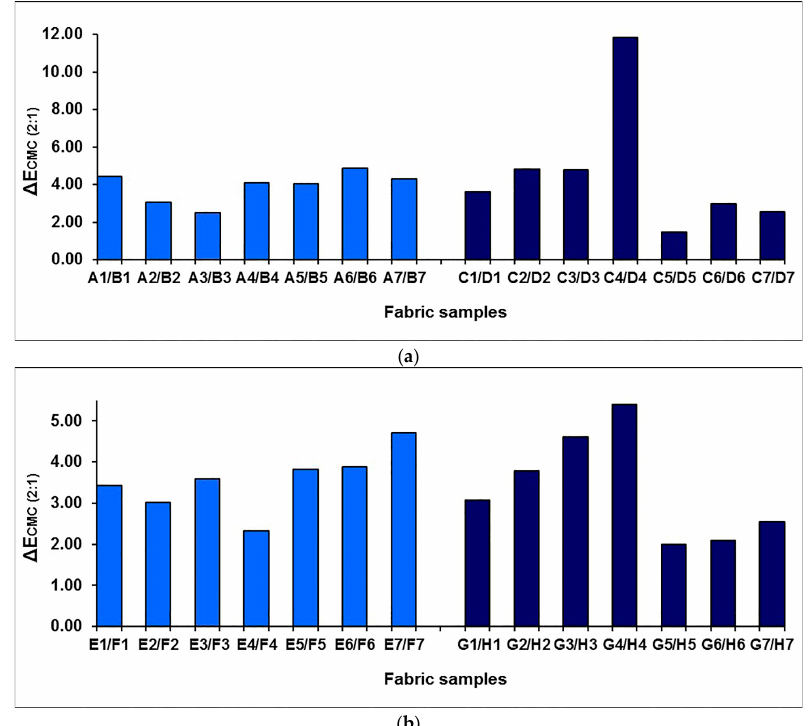
Figure 13. The color differences between lower and higher weft density: ( a ) blue-red mixed fabrics; ( b ) yellow-green mixed fabrics.